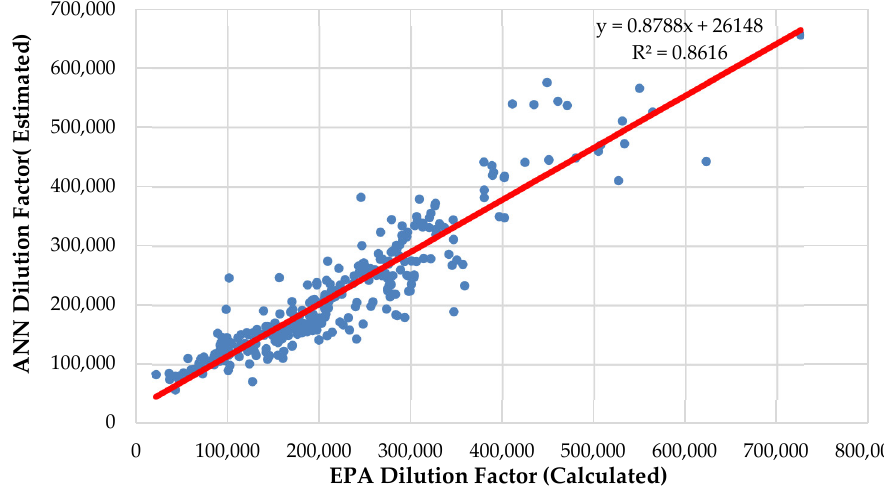
Figure 4. Calculated and estimated dilution factors for all input values DF ANN = f ( GT , DWT , PASS , FRB , EP , PROP , CB ))